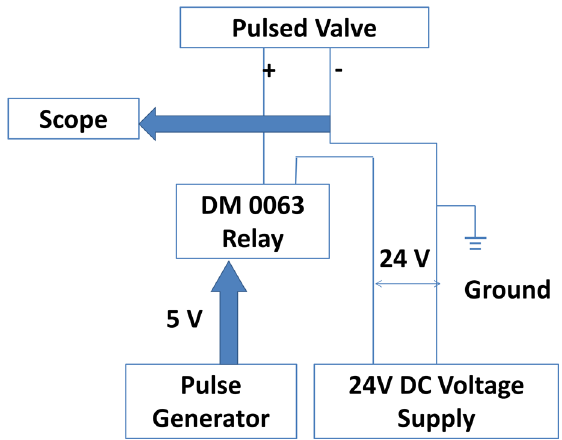
FIG. 3. Illustration of the pulsed valve operation and